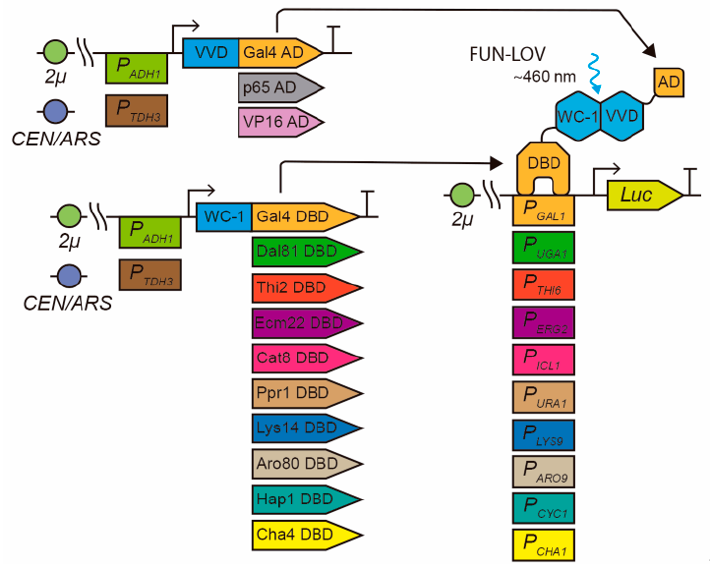
Figure 1. Modular and molecular optimization strategy used in the FUN-LOV optogenetic switch. For the modular optimization of FUN-LOV, the Gal4p DNA-binding domain (DBD) module was replaced with nine different DBDs belonging to the Zinc cluster family of transcription factors. The Gal4p activation domain (AD) module was replaced with the p65 and VP16 ADs. For the molecular optimization of FUN-LOV, the components were cloned into multicopy plasmids (2µ replication origin) or low-copy plasmids (CEN/ARS) and expressed under the control of promoters of different strengths ( P ADH1 or P TDH3 ).